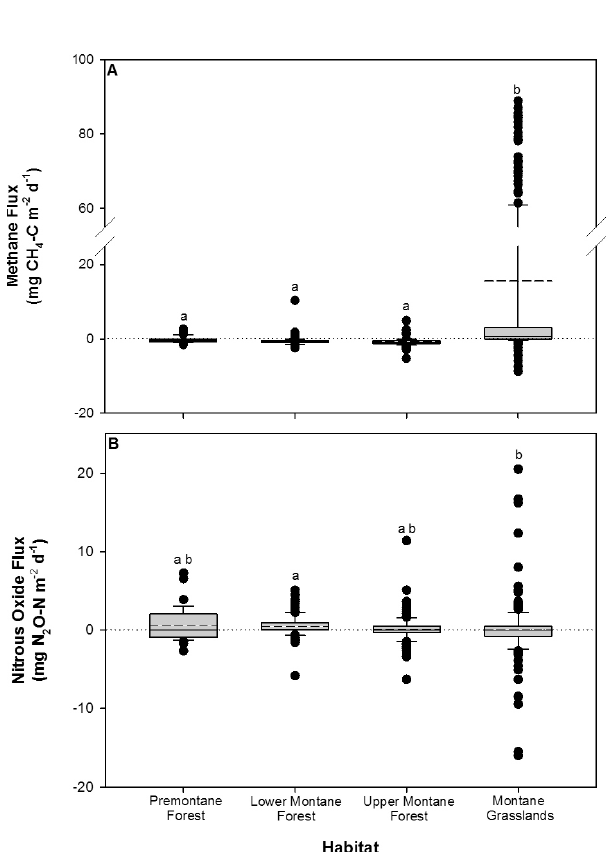
Fig. 2. (A) Net CH 4 and (B) net N 2 O fluxes by habitat. The short- dash line within each box represents the mean, whereas the solid line represents the median. Boxes enclose the interquartile range, whiskers indicate the 90th and 10th percentiles. The dotted line running across the boxes indicates zero net flux. Kruskal–Wallis ANOVA ( P < 0.05) was used to test for differences among habi- tats. Lower case letters indicate statistically significant differences among means (Fisher’s LSD on rank transformed data, P <